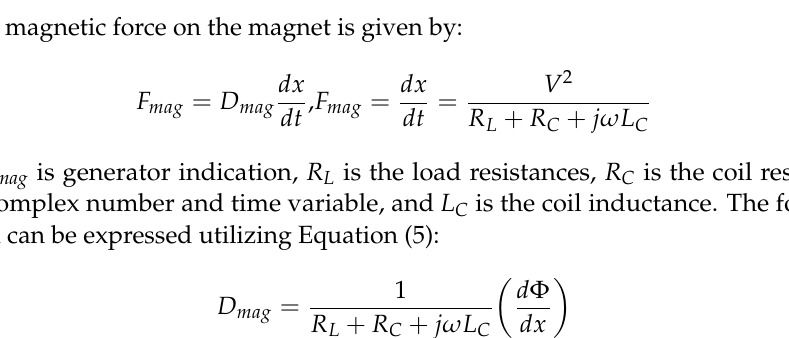
Figure 3. Feature of the electromagnetic energy harvester [30]. (Reprinted from ref. [30]).